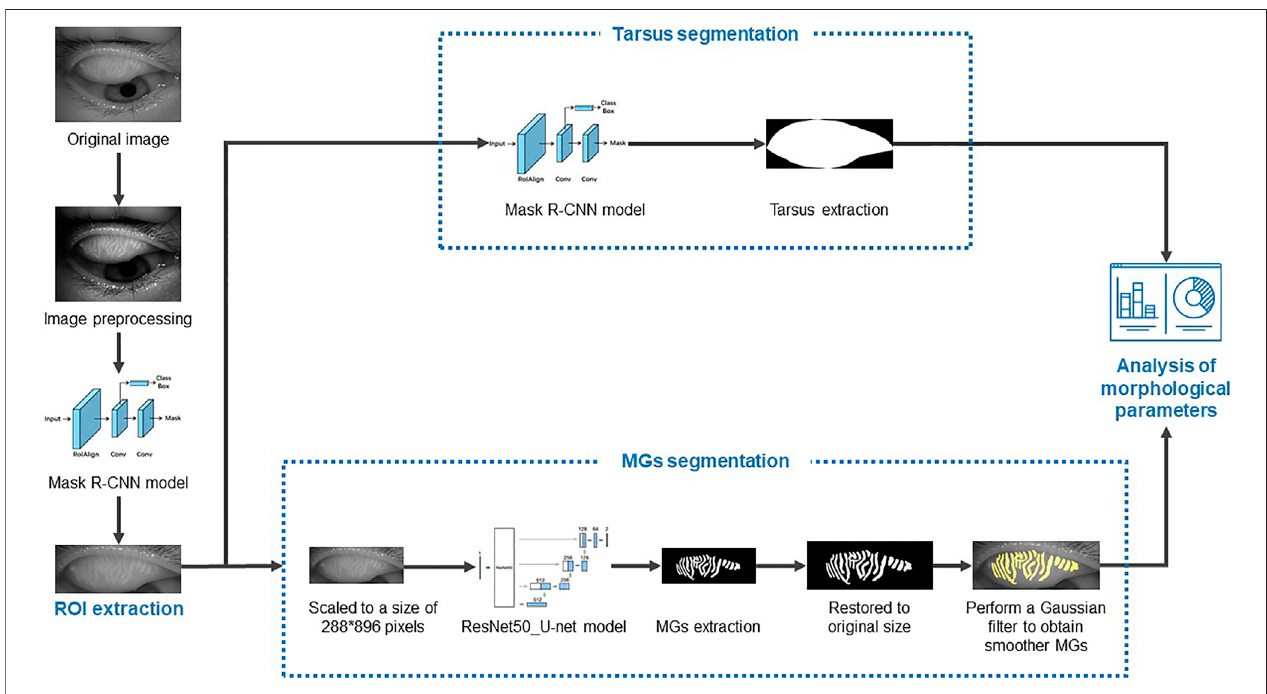
FIGURE 1 | The fl owchart of image processing and